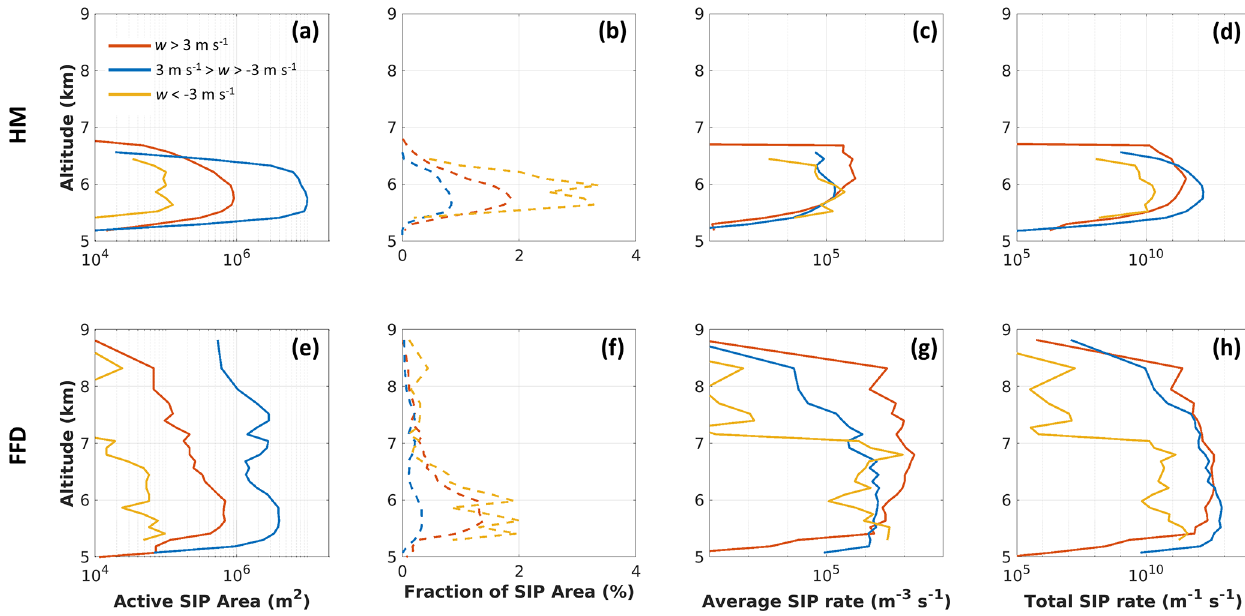
Figure 17. Panel (a) presents the area (in m 2 ) with an active HM process; panel (b) presents the fraction of area with an active HM process; panel (c) displays the average rate of SIP by the HM process within the active area shown in panel (a) ; and panel (d) shows the total SIP rate, which is the product of panels (a) and (c) . Panels (e) – (h) are the same as panels (a) – (d) but for the FFD process. Red lines (updrafts) denote SIP with w > 3ms − 1 , blue lines (outside of updrafts/downdrafts) denote SIP with w between − 3 and 3ms − 1 , and yellow lines (downdrafts) denote SIP with w < − 3ms − 1 . All results are temporal averages between 90 and